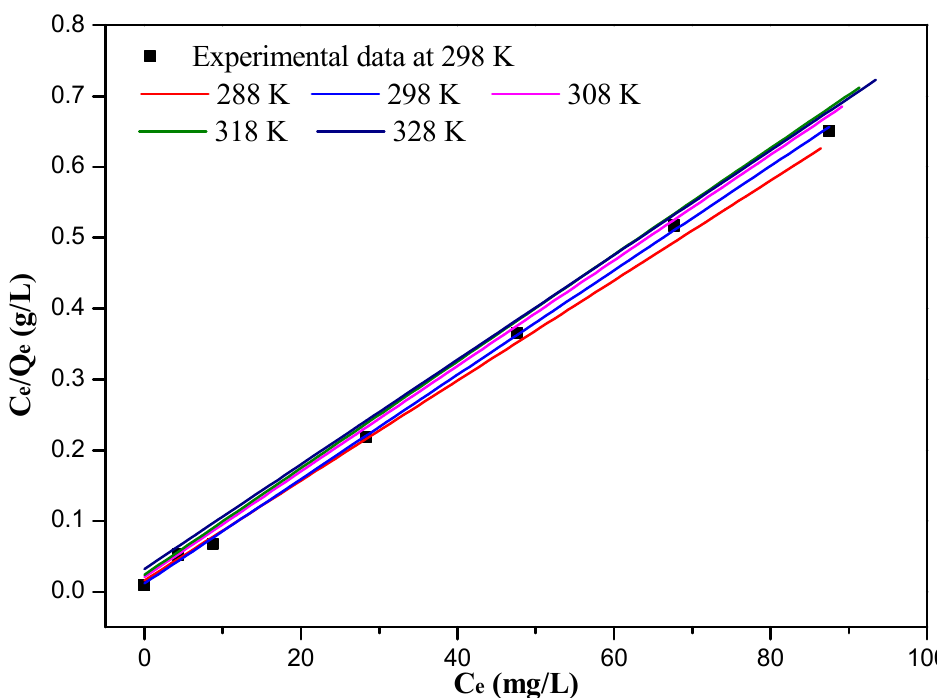
Figure 6. Experimental data at 298 K and Langmuir isotherm plots for the adsorption of Cr(VI) ions at different temperatures.